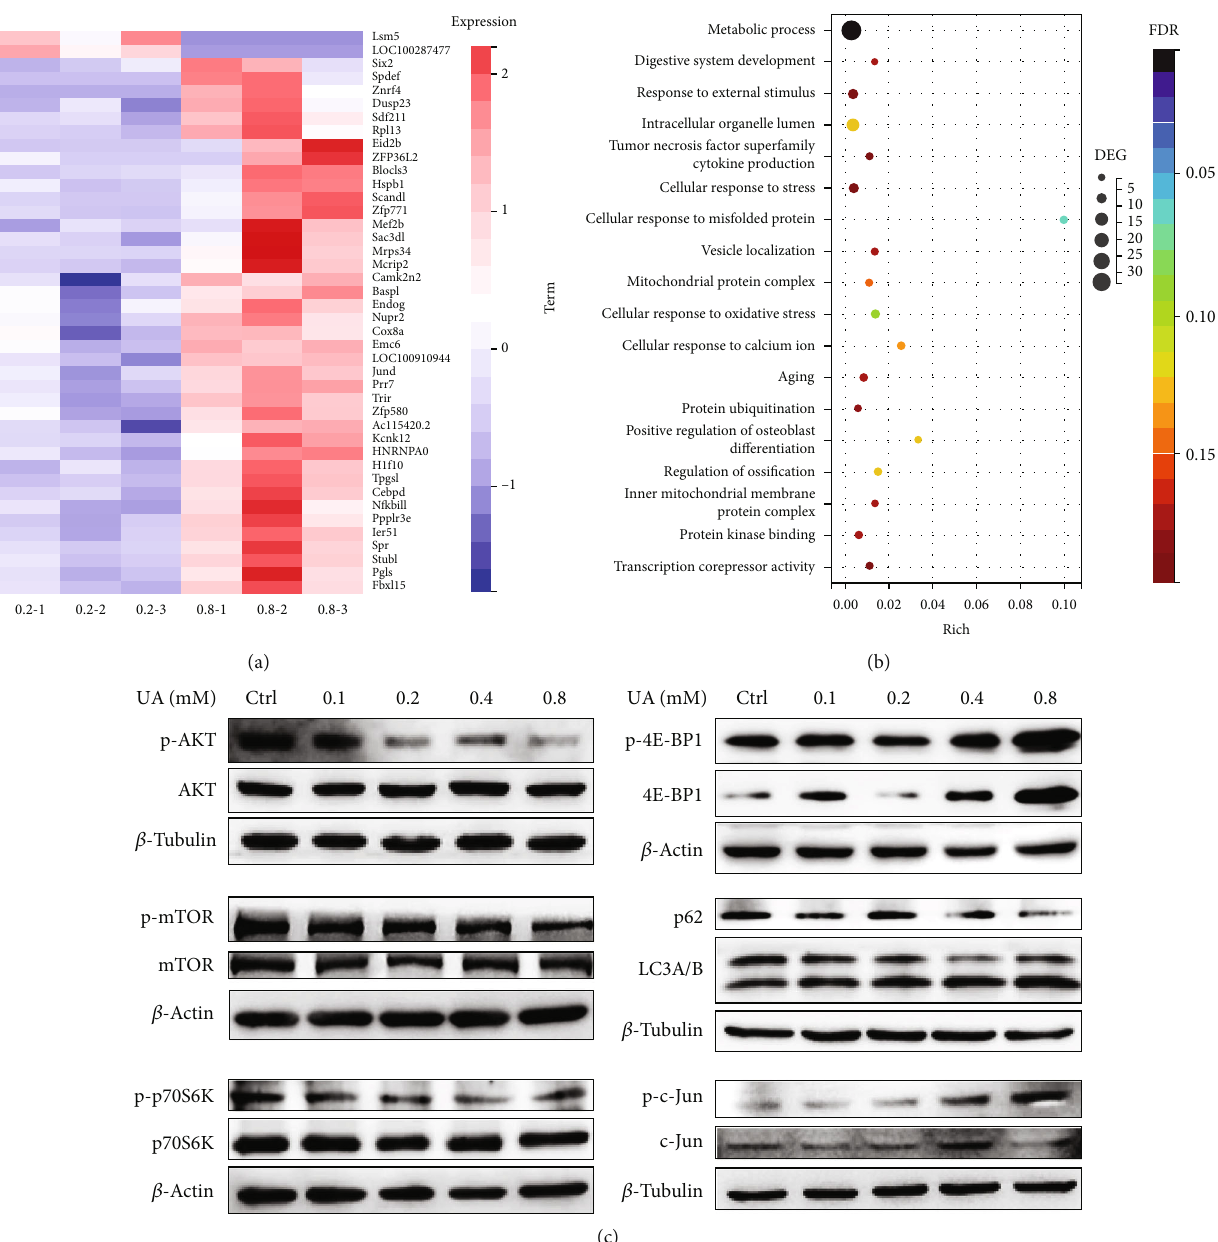
Figure 5: Analysis of the transcriptome and protein expressions in TSPCs treated with di ff erent concentrations of UA. (a) Heat map visualization of DEG between TSPCs exposed to UA at the physiological level (0.2 mM) and the level corresponding to hyperuricemia (0.8 mM) for 48 h. (b) GO enrichment of gene sets from TSPCs impacted by hyperuricemia. (c) Cell lysates of TSPCs treated with PBS or various doses of UA for 48h were tested for the AKT-mTOR pathway, the autophagy markers, and c-Jun activation by Western blot analysis. Results are representative of at least 3 independent